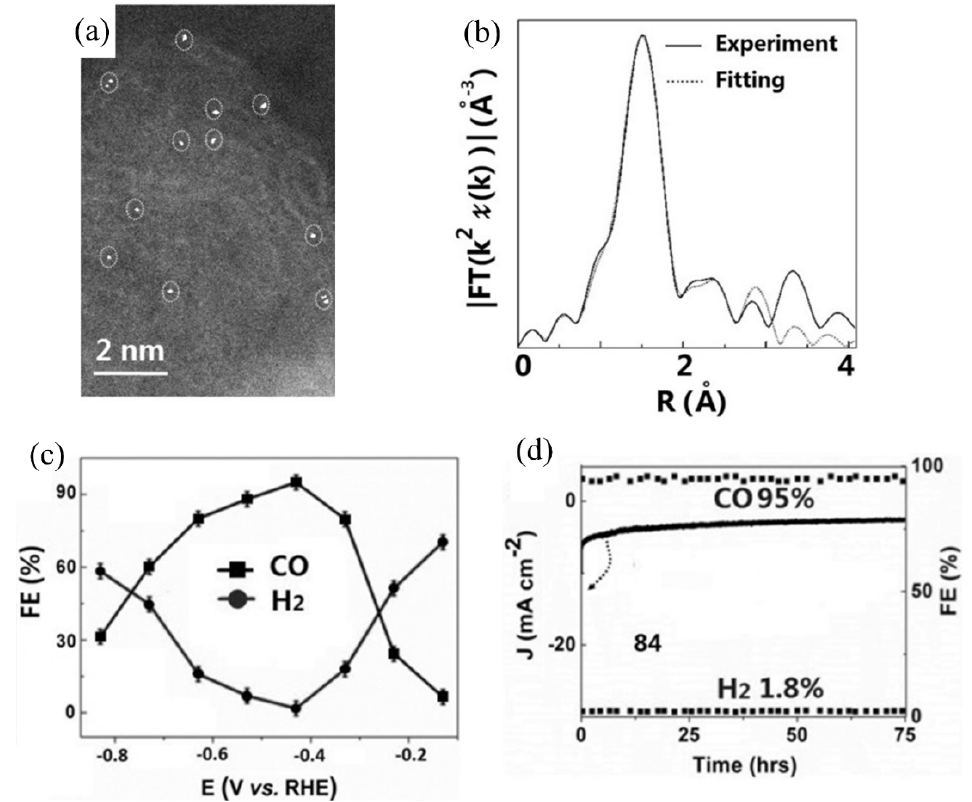
Figure 10. ( a ) Typical high-angle annular dark-field scanning transmission electron microscope (HAADF-STEM) image of the optimal ZnN x /C catalyst. The circles indicate the individual Zn atoms. ( b ) A typical fitting curve of the EXAFS signal in R-space for the adsorbed ZnN x /C catalyst. ( c ) FEs of CO and H 2 at various applied potentials on ZnN x /C catalyst. ( d ) Long-term stability of ZnN x /C at a potential load of − 0.43 V and the corresponding FEs of CO and H 2 . Reprinted from [102] Copyright (2018), with permission from Wiley.